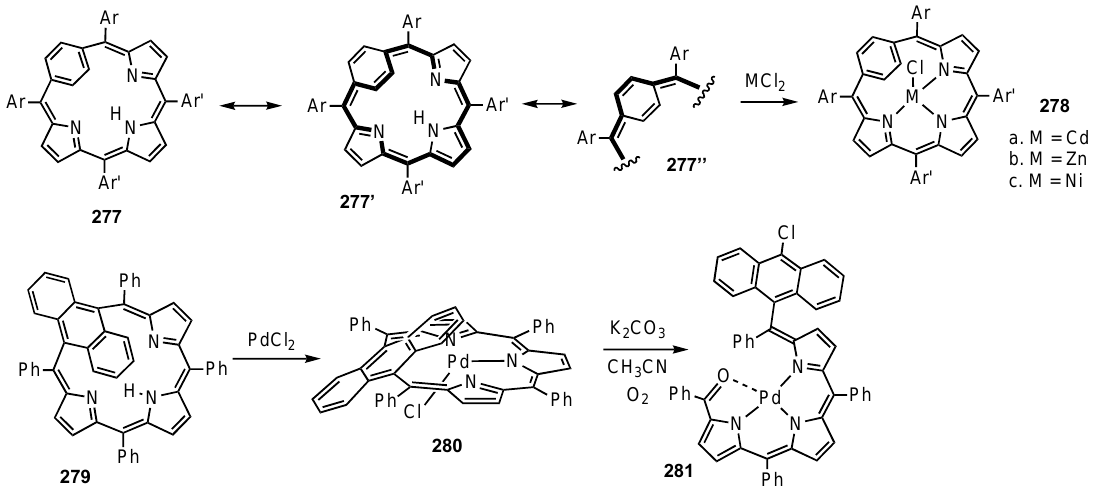
Scheme 45. Metal complexes of p -benziporphyrins and anthriporphyrin. p -Benziporphyrins undergo ring contractions with transition metal cations to give palladium, rhodium and gold carbaporphyrin complexes. Reaction of 277 with PdCl 2 in acetonitrile gave chloropalladium derivative 282 (Scheme 46) [197]. As is the case for other p -benziporphyrin complexes, the metal cation is involved in an η 2 -interaction with the